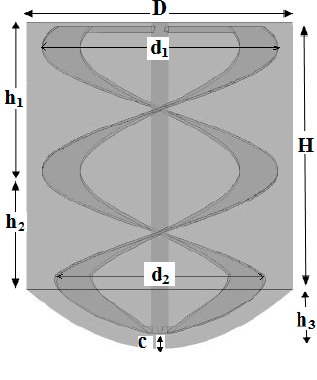
Figure 1. Stirred system. Table 1. Geometrical parameters of mixing vessels with a flat bottom vessel.